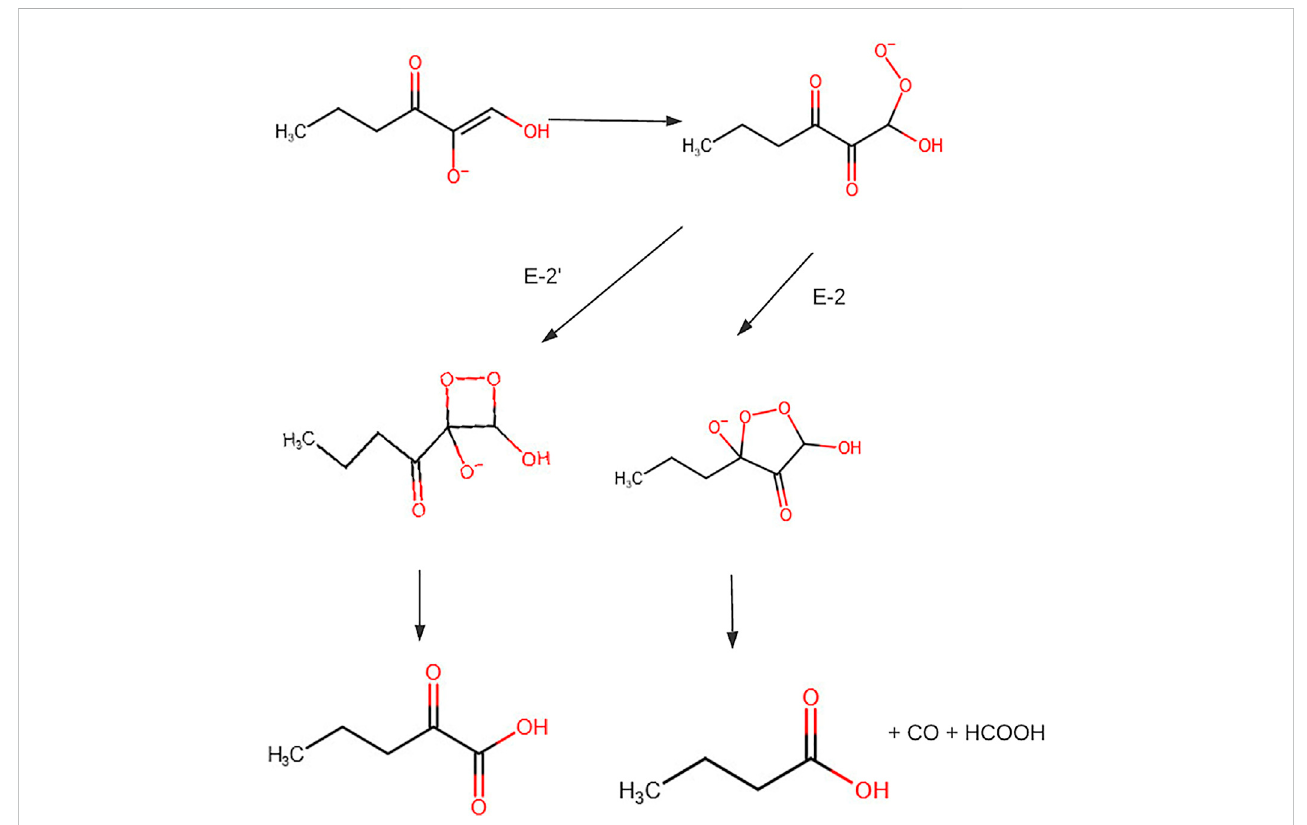
FIGURE 8 Conversion of S-methylthioadenosine to methionine. Figure redrawn after reference (Dai et al.,